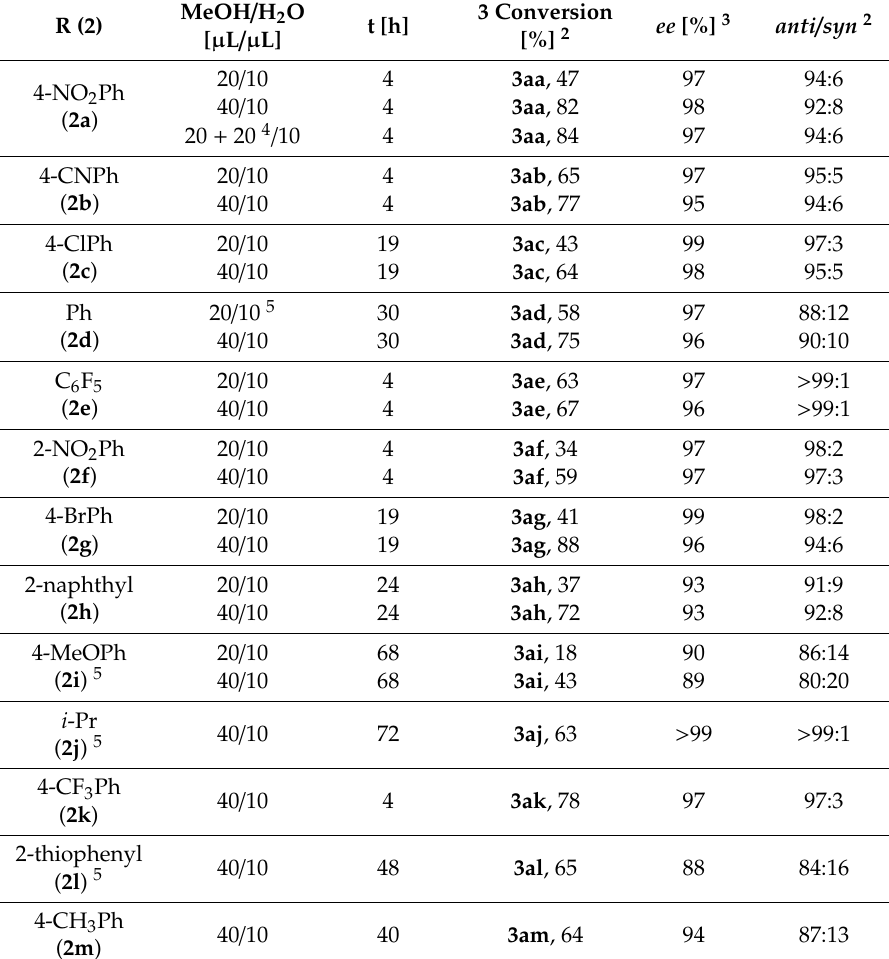
Table 3. Optimization of the MeOH / H 2 O-based protocol 1